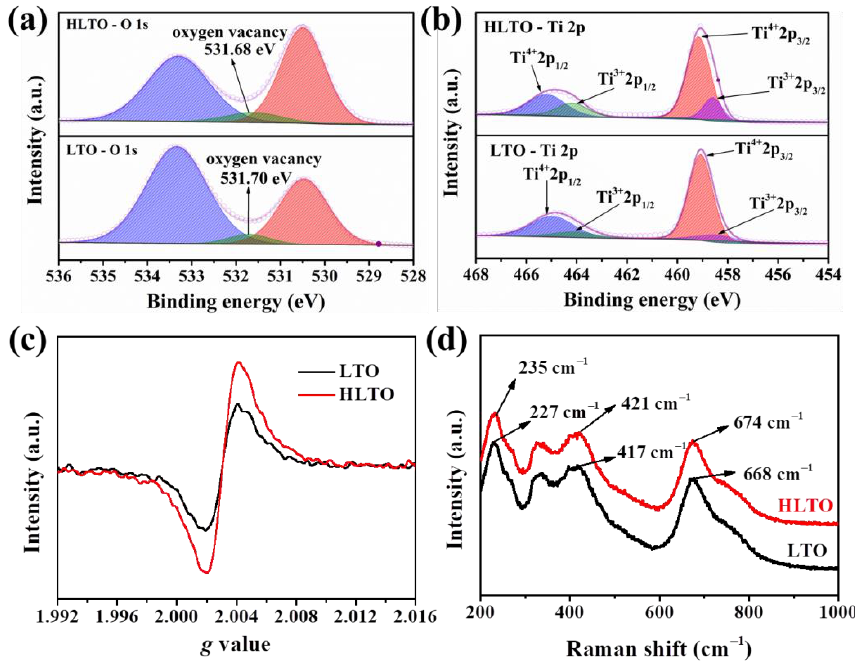
Figure 3. Characterization results of HLTO and LTO: High-resolution XPS spectra of ( a ) O 1s and ( b ) Ti 2p; ( c ) electron paramagnetic resonance (EPR) spectra; ( d ) Raman scattering spectra.